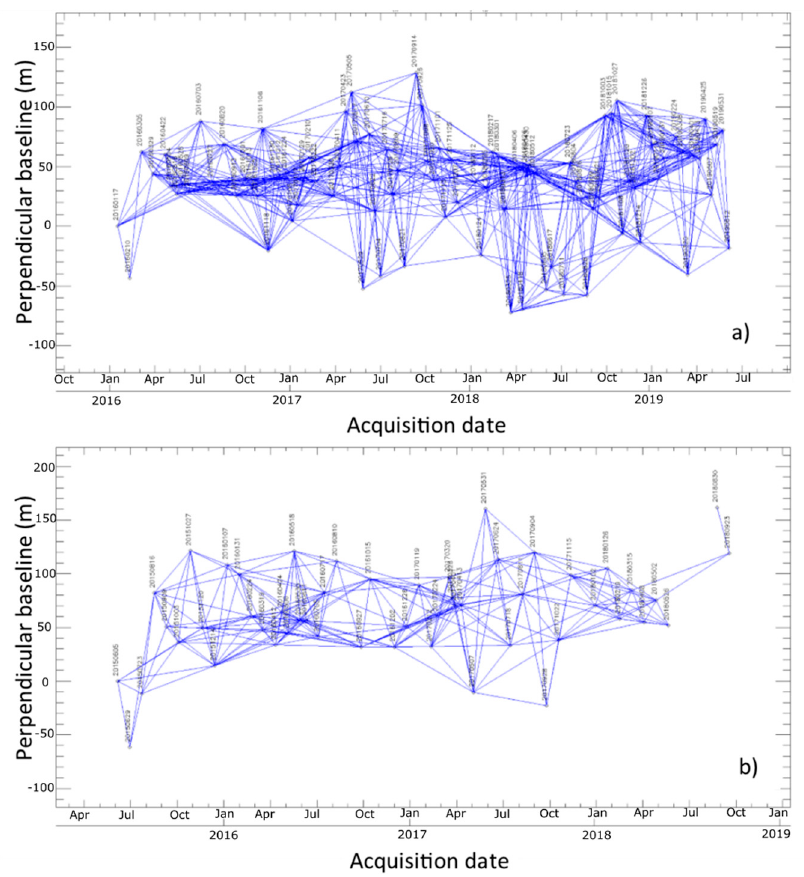
Figure 4. Interferograms distribution in ( a ) ascending; ( b ) descending.